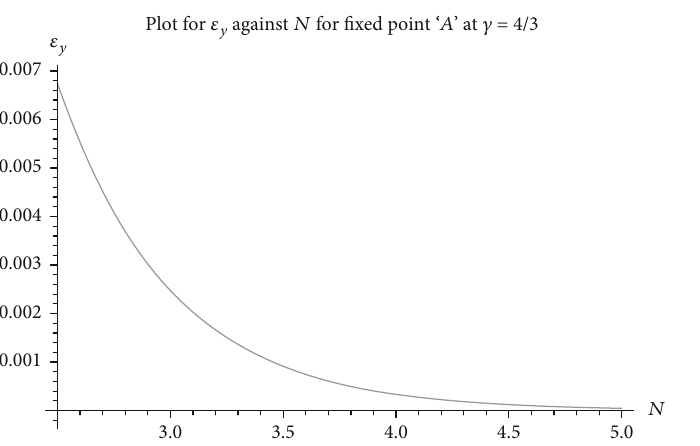
Figure 11: Shows the variation of perturbations along the y -axis against N at γ = 4/3 for the fi xed point A .